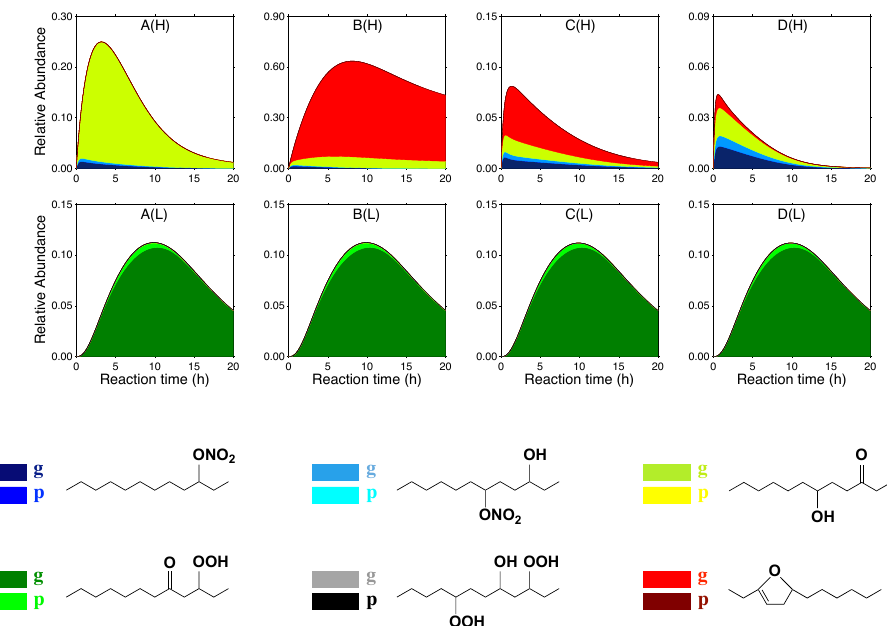
Figure 3. Model-predicted relative abundance of δ -hydroxycarbonyl and alkyl-substituted dihydrofuran, together with other first-generation products under high-NO x (H) and other third-generation products under low-NO x (L) conditions in gas (g) and particle (p) phases. All the organic masses are normalized by the initial organic mass ( ∼ 200ppb dodecane). (A) represents the relative abundance of products without a heterogeneous alkyl-substituted dihydrofuran formation channel, (B) represents the relative abundance of products when the heterogeneous channel is incorporated into the scheme but in the absence of any sink of alkyl-substituted dihydrofuran, (C) represents the relative abundance of products when the OH oxidation is the only sink of alkyl-substituted dihydrofuran, and (D) represents the relative abundance of products using the complete gas- and particle-phase mechanism.